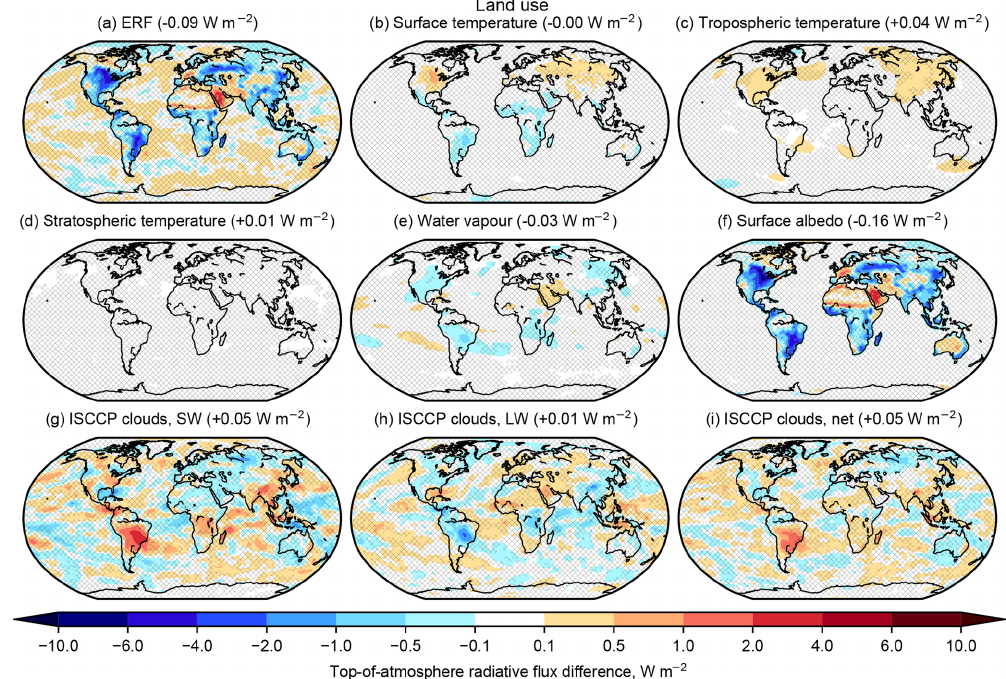
Figure 12. As Fig. 6 but for present-day land use forcing. Panel (f) represents the IRF in this experiment.